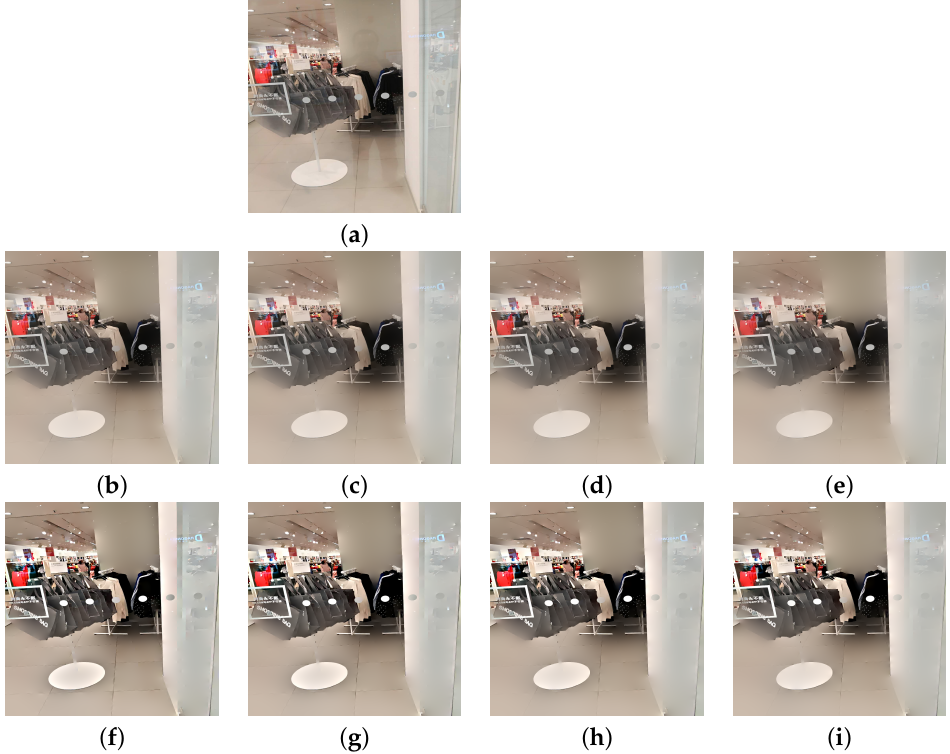
Figure 9. Reflection suppression results for real glass image ‘Mall’. ( a ) Input image. ( b – e ) The results of proposed algorithm (under ϕ = 1) with N = 1,2,3,4, respectively. ( f – i ) The results of algorithm (under ϕ in (12) and β = 1) with N = 1,2,3,4,